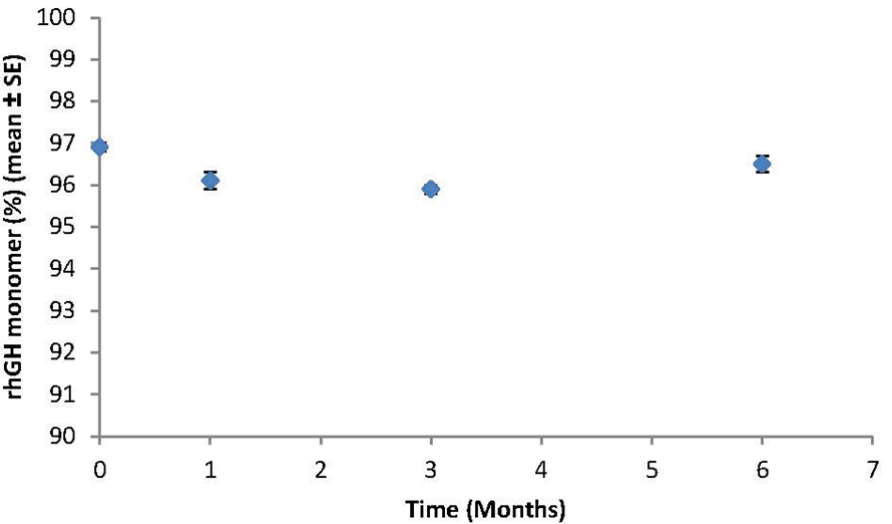
Figure 4. Comparison of the purity of rhGH active pharmaceutical ingredient (API)